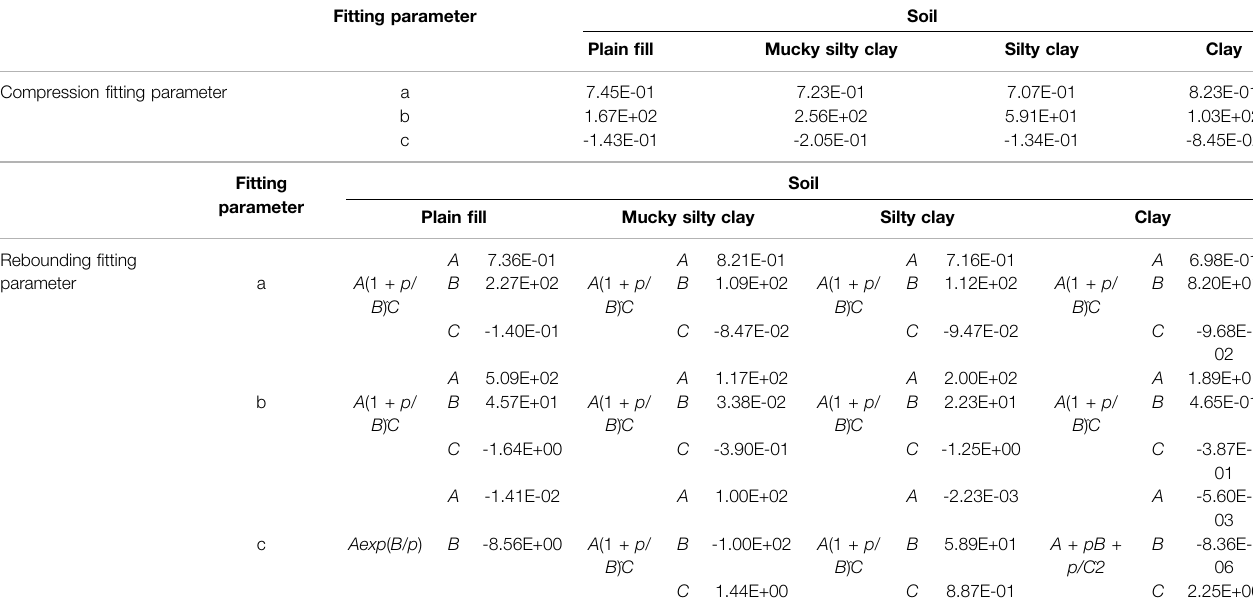
TABLE 2 | Fitting parameters of the compression and rebound